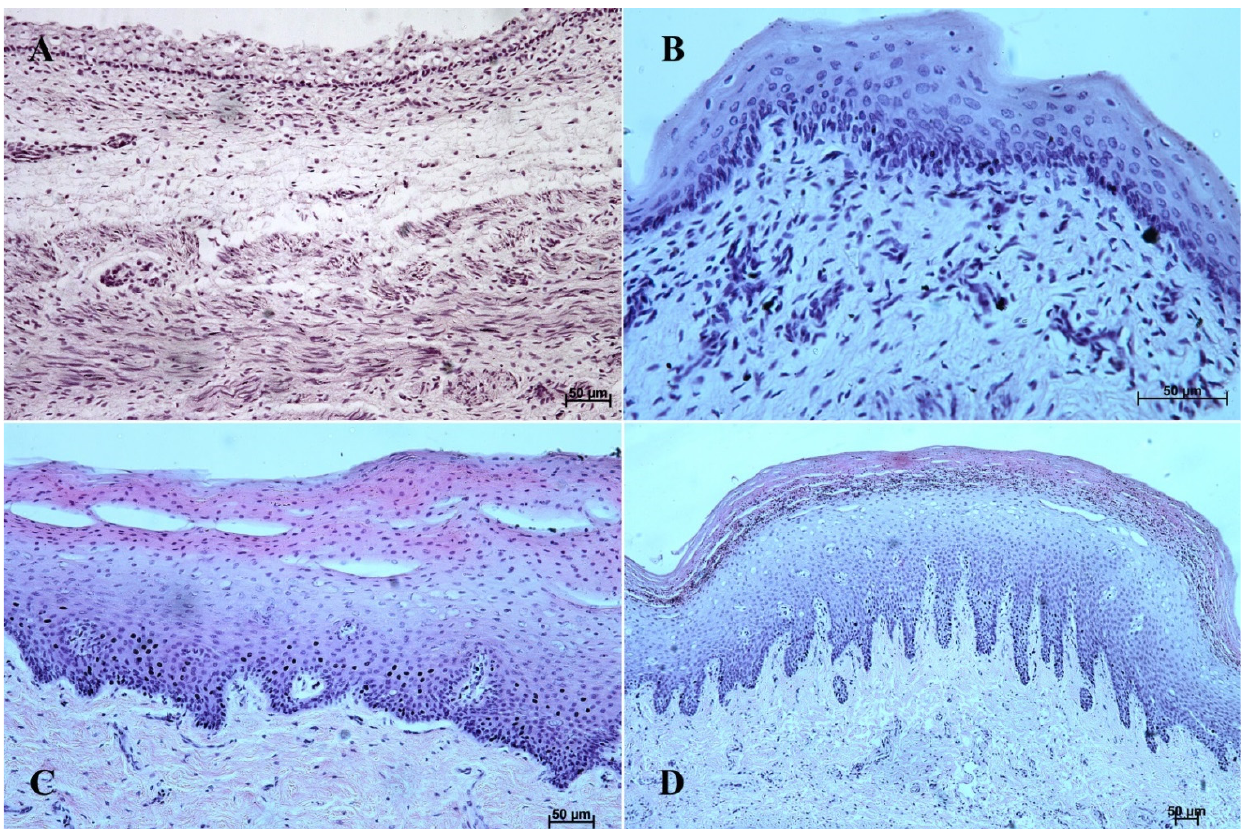
Figure 2. Histological structure of the stomach mucosa in the nonglandular part (hematoxylin-eosin staining). ( A )—the first age group (20×); ( B )—the second age group (40×); ( C )—the third group (20×); ( D )—the reference adult group (10×).